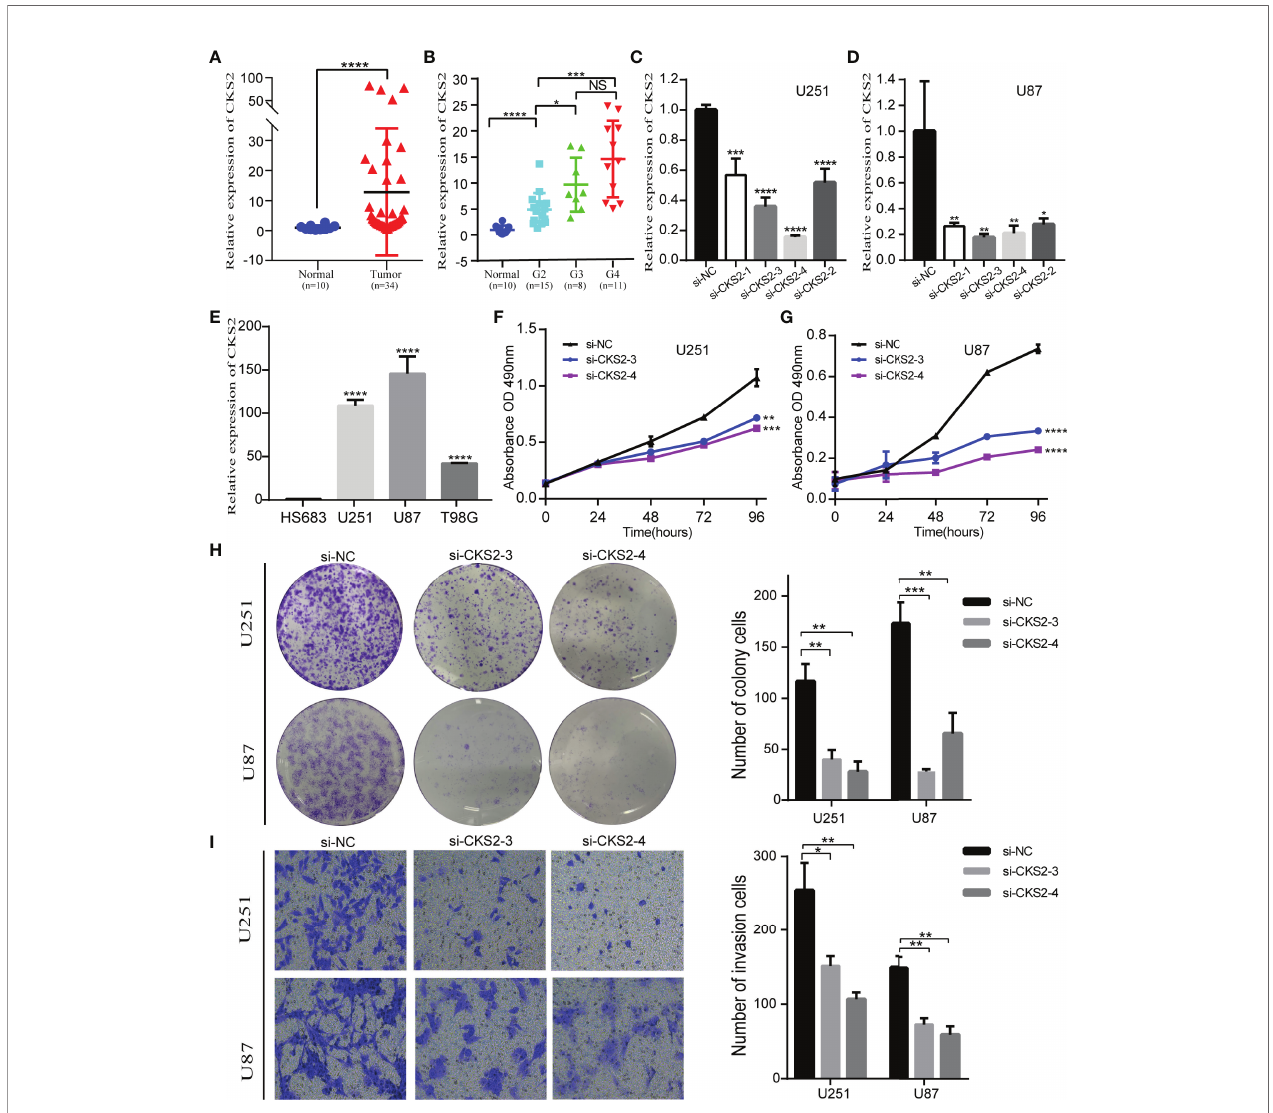
FIGURE 9 | Deletion of CKS2 inhibits the proliferation and invasive abilities of glioma cell lines. (A) On the basis of the qRT-PCR analysis, CKS2 expression was particularly upregulated in glioma tissues (n = 34) compared to normal brain tissues (n = 10). (B) The association between CKS2 expression and histological grade (n = 34). (C, D) In U251 and U87 cells, the expression of CKS2 was downregulated in the siRNA group. (E) The expression of CKS2 in various glioma cell lines. (F, G) MTS assay to detect U251 transfected with si-CKS2 and the proliferation inhibition of U87 cells. (H, I) Colony formation and transwell assays showed that CKS2 downregulation greatly hindered the proliferation and invasion of U251 and U87 cell lines compared with the control group. * p <0.05, ** p <0.01, *** p <0.001, and **** p